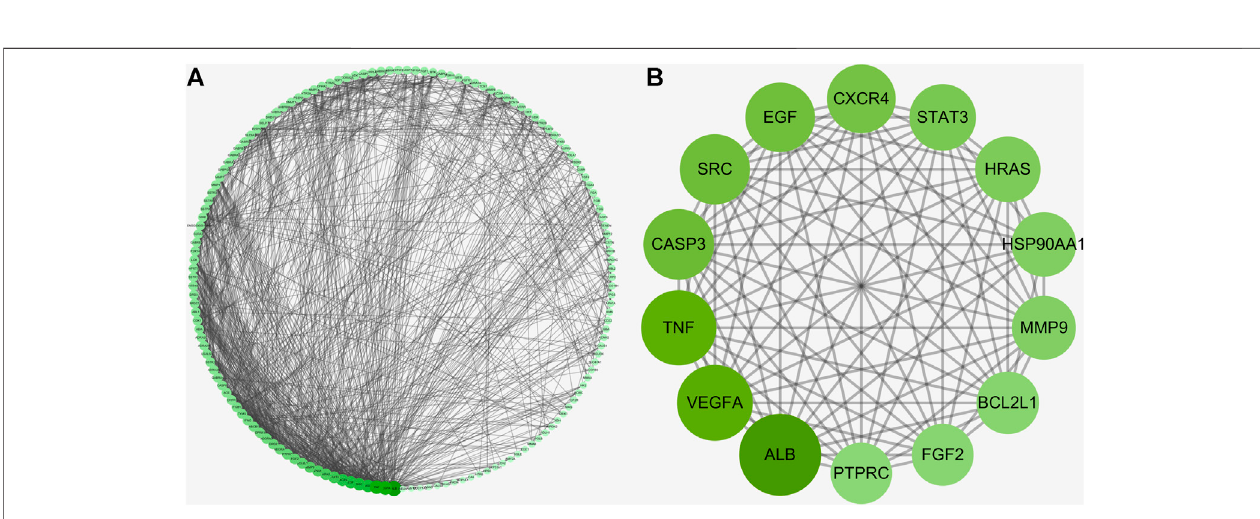
FIGURE 2 | Hub targets of a PPI network (A) for uncovering all crucial targets of Pachyman in treating HCC (B) .